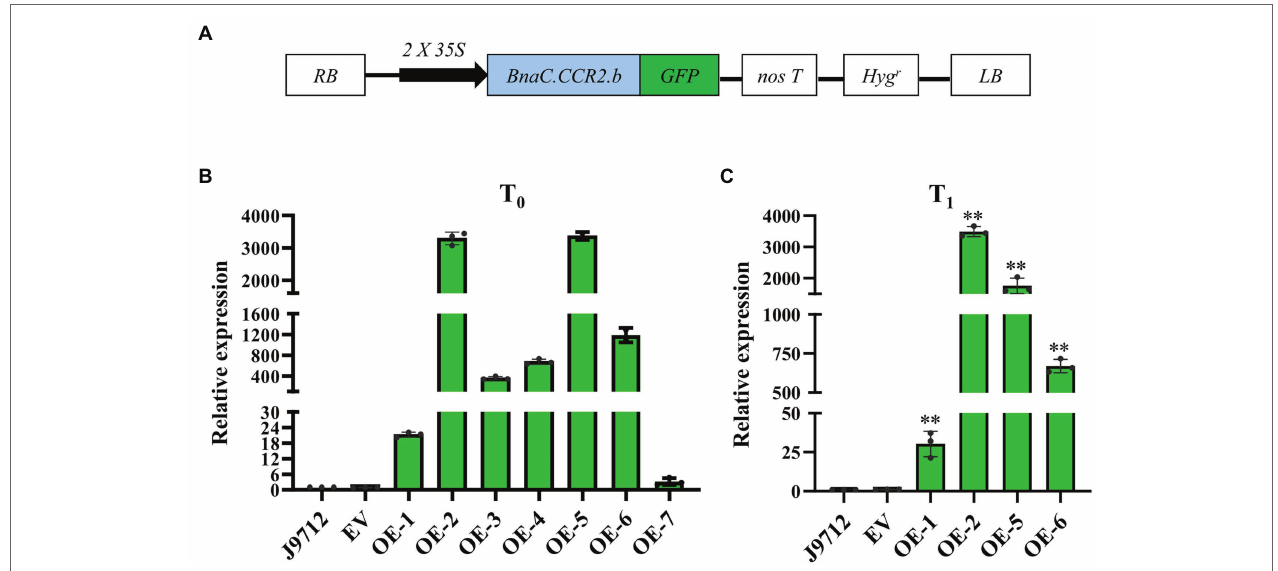
FIGURE 3 | Schematic of the BnaC.CCR2.b overexpression construct and expression analysis of BnaC.CCR2.b in transgenic plants. (A) Schematic diagram of the BnaC.CCR2.b overexpression construct. 35S : cauliflower mosaic virus 35S promoter. GFP : green fluorescent protein . NosT : nopaline synthase gene terminator. Hygr : hygromycin B resistance gene. RB and LB represent the right and left borders, respectively. (B) and (C) Expression of BnaC.CCR2.b in the stems of T 0 and T 1 transgenic lines, respectively. J9712, transgenic receptor line. EV, pMDC83 empty vector transgenic line. OE-1 to OE-7 are BnaC.CCR2.b overexpression lines. The asterisks indicate significant differences between the control and transgenic lines ( * p < 0.05; ** p < 0.01; and Student’s